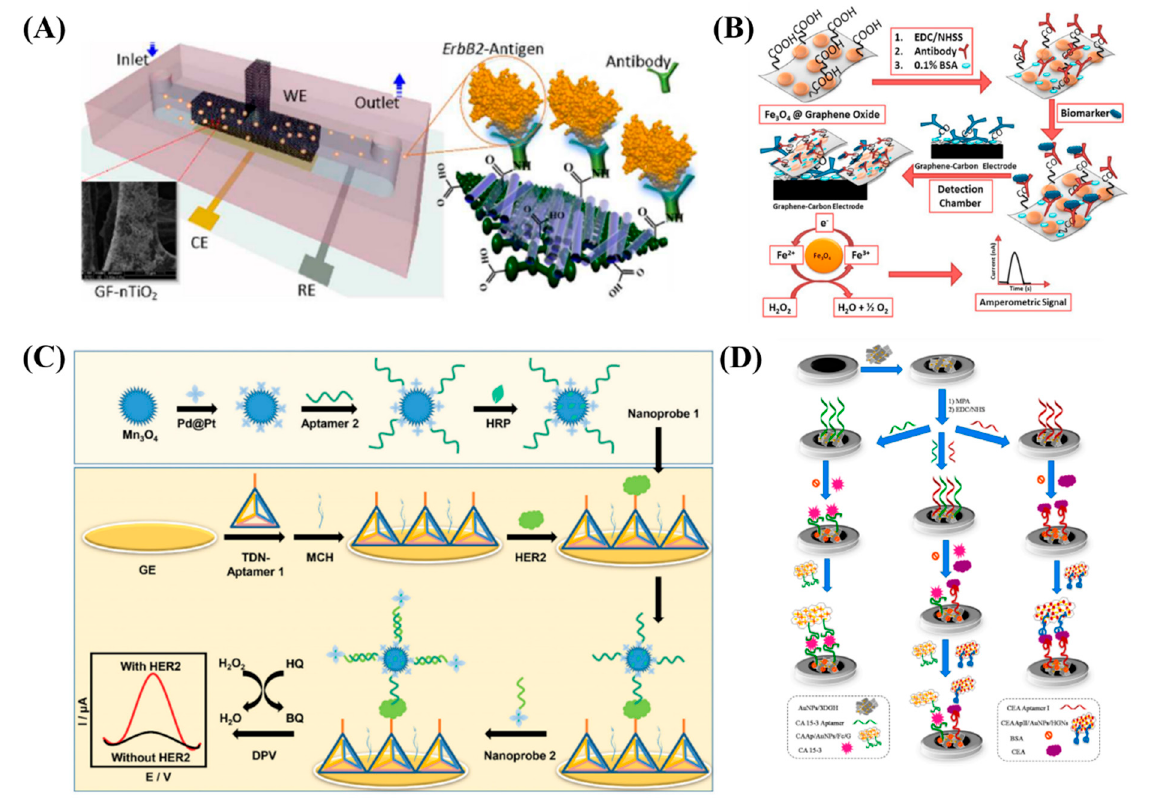
Figure 2. ( A ) Schematic representation of the graphene foam (GF) modified carbon-doped titanium dioxide nanofibers microfluidic immunosensor. Re-used with permission from Ref. [16]. (Copyright 2016 American Chemical Society) ( B ) Overall representation of the Fe 3 O 4 @GO work. Re-used with permission from Ref. [17]. (Copyright, 2017 Elsevier, reproduced with permission from Elsevier Ltd.) ( C ) Scheme of the design of electrochemical Mn 3 O 4 /Pd@Pt/HRP dual-aptamer biosensor. Re-used with permission from Ref. [18] (Copyright, 2019 Royal society of chemistry, reproduced with permission from Royal society of chemistry Ltd.) and ( D ) schematic steps involved in the preparation of AuNPs/3DGH sandwich–type aptasensor. Re-used with permission from Ref. [20]. (Copyright, 2021 Elsevier, reproduced with permission from Elsevier Ltd.).